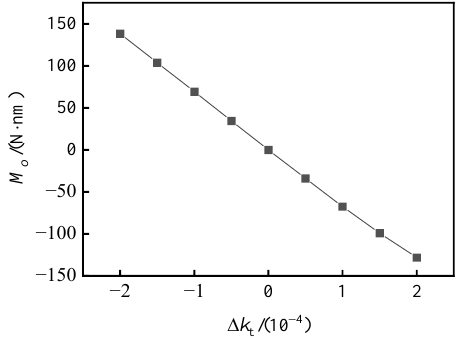
Figure 10. Interference torque versus taper error.